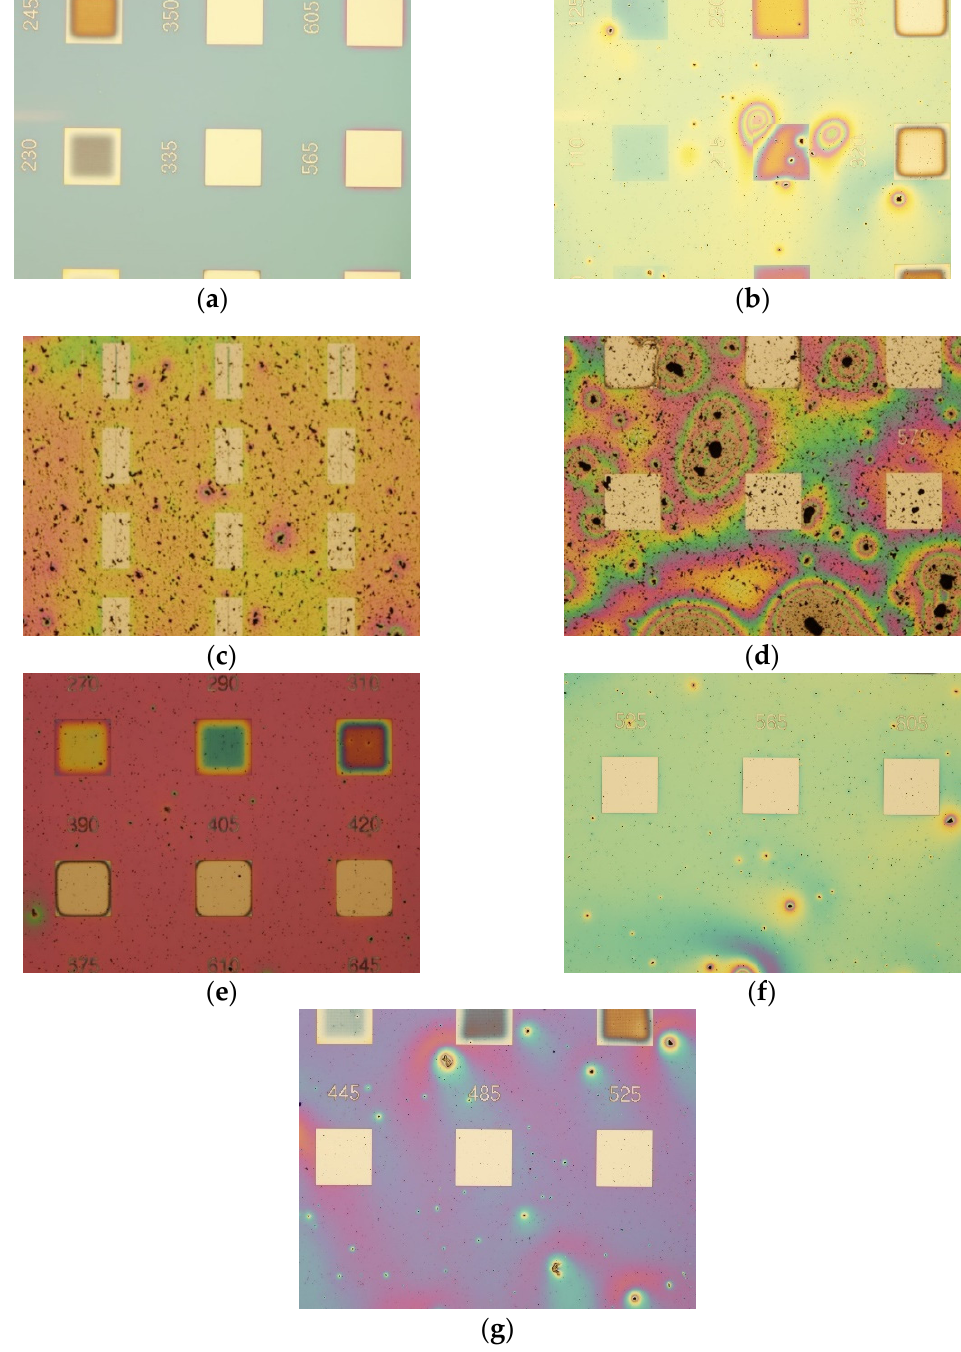
Figure 2. Optical microscope images (magnification: ×10) from the contrast curve patterns used to determine the suitability of the CuO/PMMA nanocomposites as resist materials. The square patterns have a size of 200 µ m × 200 µ m (detailed description can be found in Section 2 of SM). Analytically, ( a ) REF-1k, ( b ) 1%CuO-1k, ( c ) 2%CuO-1k (picture of resolution structures to demonstrate their characteristic pattern), ( d ) 3%CuO-1k, ( e ) 1%CuO-1k-DF, ( f ) 1%CuO-3k, and ( g ) 1%CuO-4k.